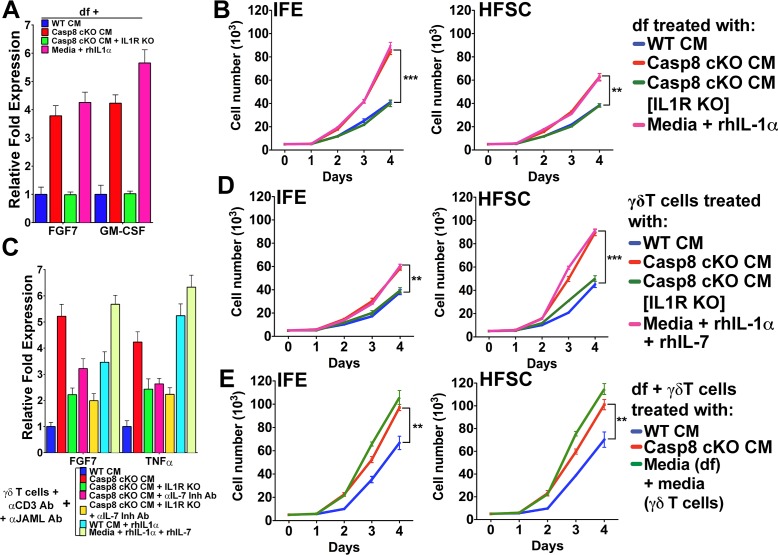
Conditioned media from dermal fibroblasts and activated γδT-cells differentially enhance epithelial stem cell proliferation in distinct niches within the skin.(A) Activation of dermal fibroblasts (df). df were treated with conditioned media (CM) as noted in the figure and the expression of the growth factors FGF7 and GM-CSF were assessed by qPCR. (B) Effect of activated df on stem cell proliferation. The proliferation rates of isolated interfollicullar epidermal (IFE) and hair follicle stem cells (HFSC) were determined by cell counting with trypan blue exclusion following treatment with the CM from dermal fibroblasts. Dermal fibroblasts were first activated as described in the figure legend prior to conditioning fresh medium with them. Cell numbers were determined daily over four days. (C) Potentiation of γδT-cell activation by CM. WT or IL1R–/– γδT-cells were treated with CM as described in the figure, and the markers for γδT-cell activation, FGF7 and TNFα, were assessed by qPCR. (D) Effect of activated γδT-cells on stem cell proliferation. The proliferation rates of isolated IFE and HFSC were determined by trypan blue exclusion cell counting. IFE and HFSC were incubated for four days with CM from γδT-cells. (E) Combinatorial effect of activated df and γδT-cells on stem cell proliferation. The proliferation rates of isolated IFE and HFSC were determined by trypan blue exclusion cell counting. IFE and HFSC were incubated for four days with CM from df and γδT-cells that were first treated as described in the figure. Data in (A) and (C) were obtained from triplicates of at least three independent experiments and are represented as the fold difference ± SEM. The data shown in (B), (D) and (E) are the averages ± SEM of three independent experiments analyzed in triplicate. **p<0.001, ***p<0.0001.